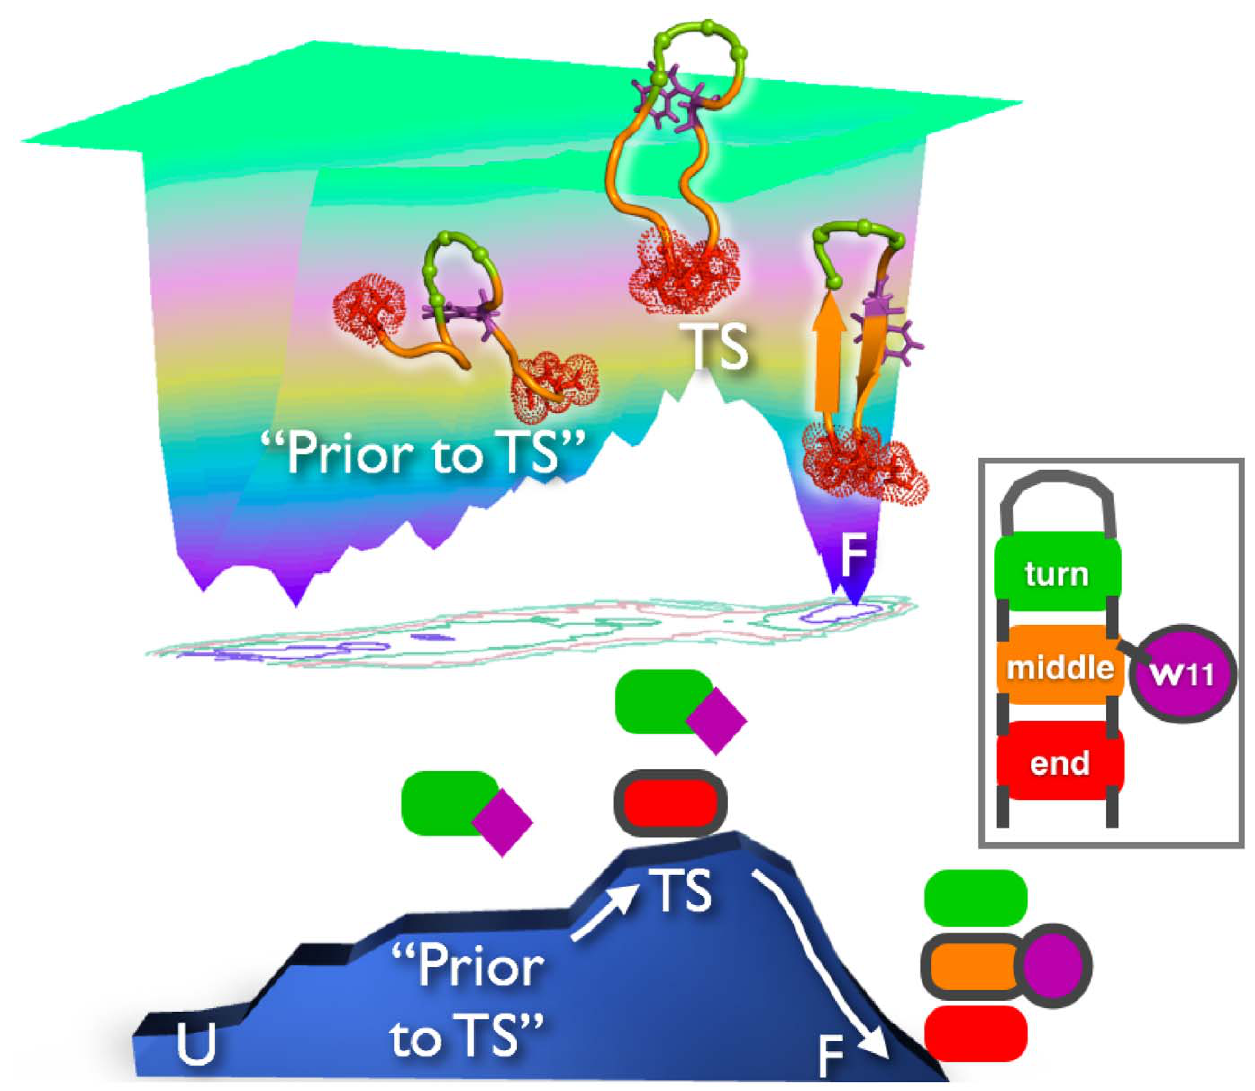
Figure 10. Three-dimensional representation of folding funnel of Peptide 1. The mechanism by which the peptide crosses TS is shown. The TS is reached with the formation of native end-to-end (red) and turn (green) contacts, with the end-to-end formation appearing at the TS, making it the unique feature of the TS of Peptide 1. However, reaching the folded state from the TS involves W11 sidechain (purple) repositioning and concomitant native arrangement of the central segment (orange) of b -hairpin. In ‘‘Prior-to-TS’’ and TS, W11 is in a ‘key-lock’ configuration with turn residues, thus from a dynamic point of view it acts as a chaperone to reach the TS, while the last stage to reach the native state involves ‘correct’ native arrangement of W11 with the central segment of b -hairpin (See representative